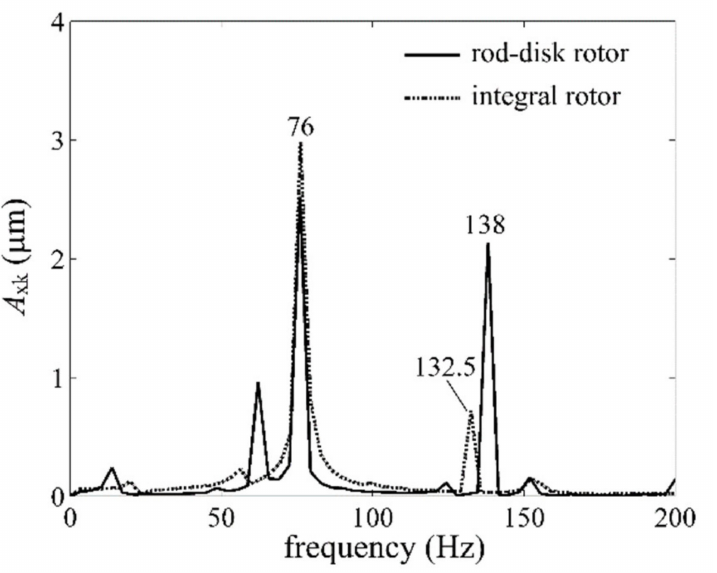
Figure 12. The frequency components of the x–direction vibration at bearing node for the flawed rod–disk and integral